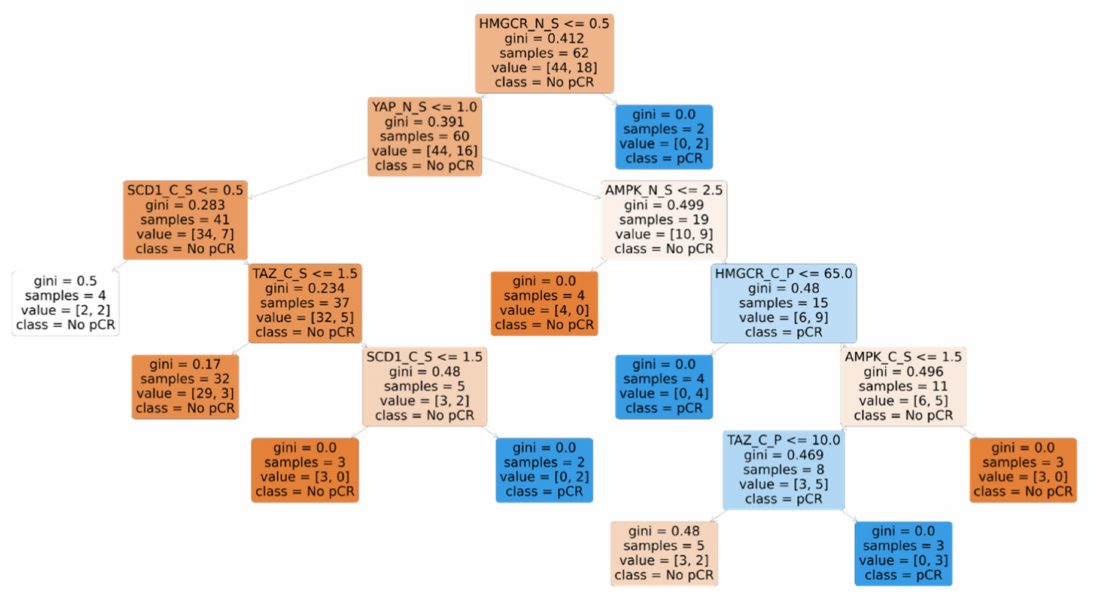
Figure 6. Decision tree that fits with hyperparameter alpha = 0.03 and with all the raw biomarker expressions as predictors of pCR. Tree interpretation: right branching = No; left branching = Yes; gini = node or leaf purity. Suffixes: _N = nuclear; _C = cytoplasmic; _S = immunoreaction intensity score; _P = percentage of cells